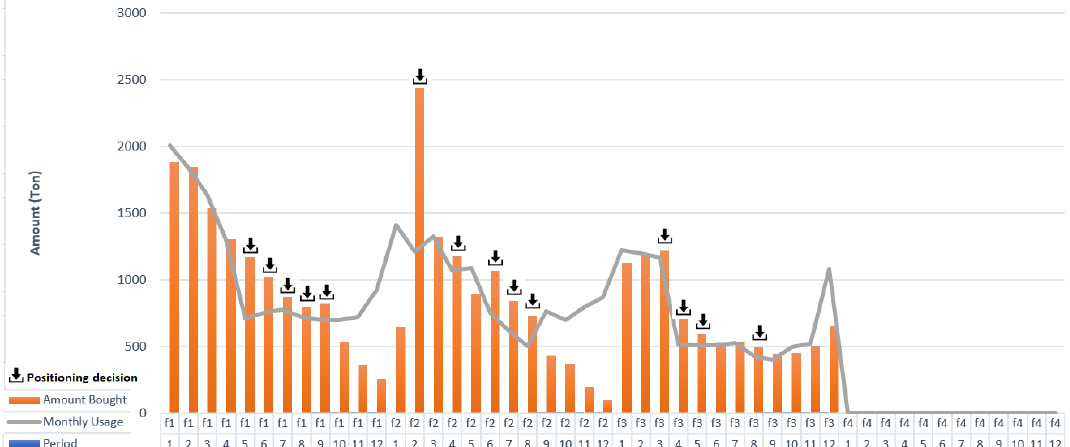
Figure 4. Purchase plan vs. monthly usage of